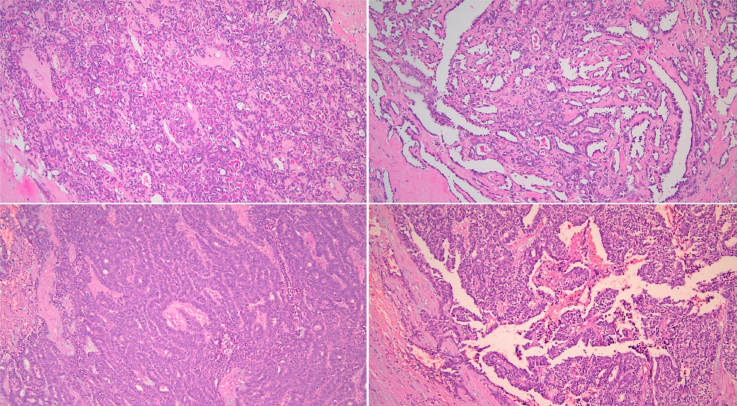
Figure 2. Mesonephric-like adenocarcinoma showing different patterns. (HE, 200 × ).